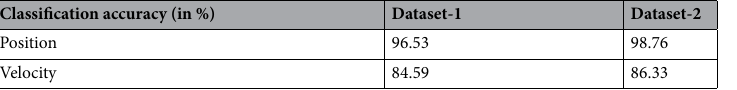
Table 1. Gender classification results using position data and velocity data for five personality traits using SVM classification on both the datasets.